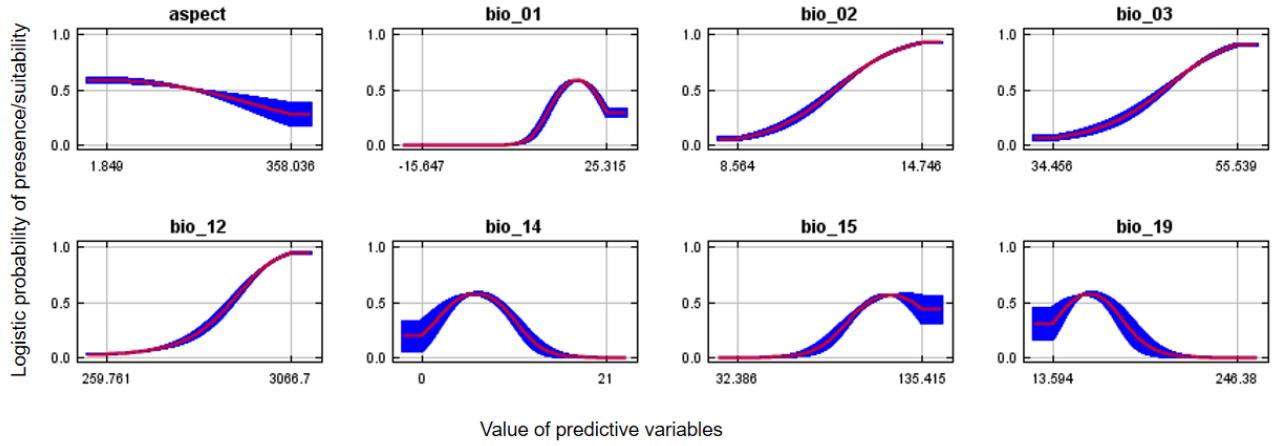
Figure 4. Response curves of aspect, mean annual temperature (bio_1), mean diurnal range (bio_02), iso-thermality (bio_3), annual precipitation (bio_12), precipitation of driest month (bio_14), precipitation seasonality (bio_15) and precipitation of coldest quarter (bio_19) on the probability of potential suitable nest habitat for Egyptian vultures, Nepal.